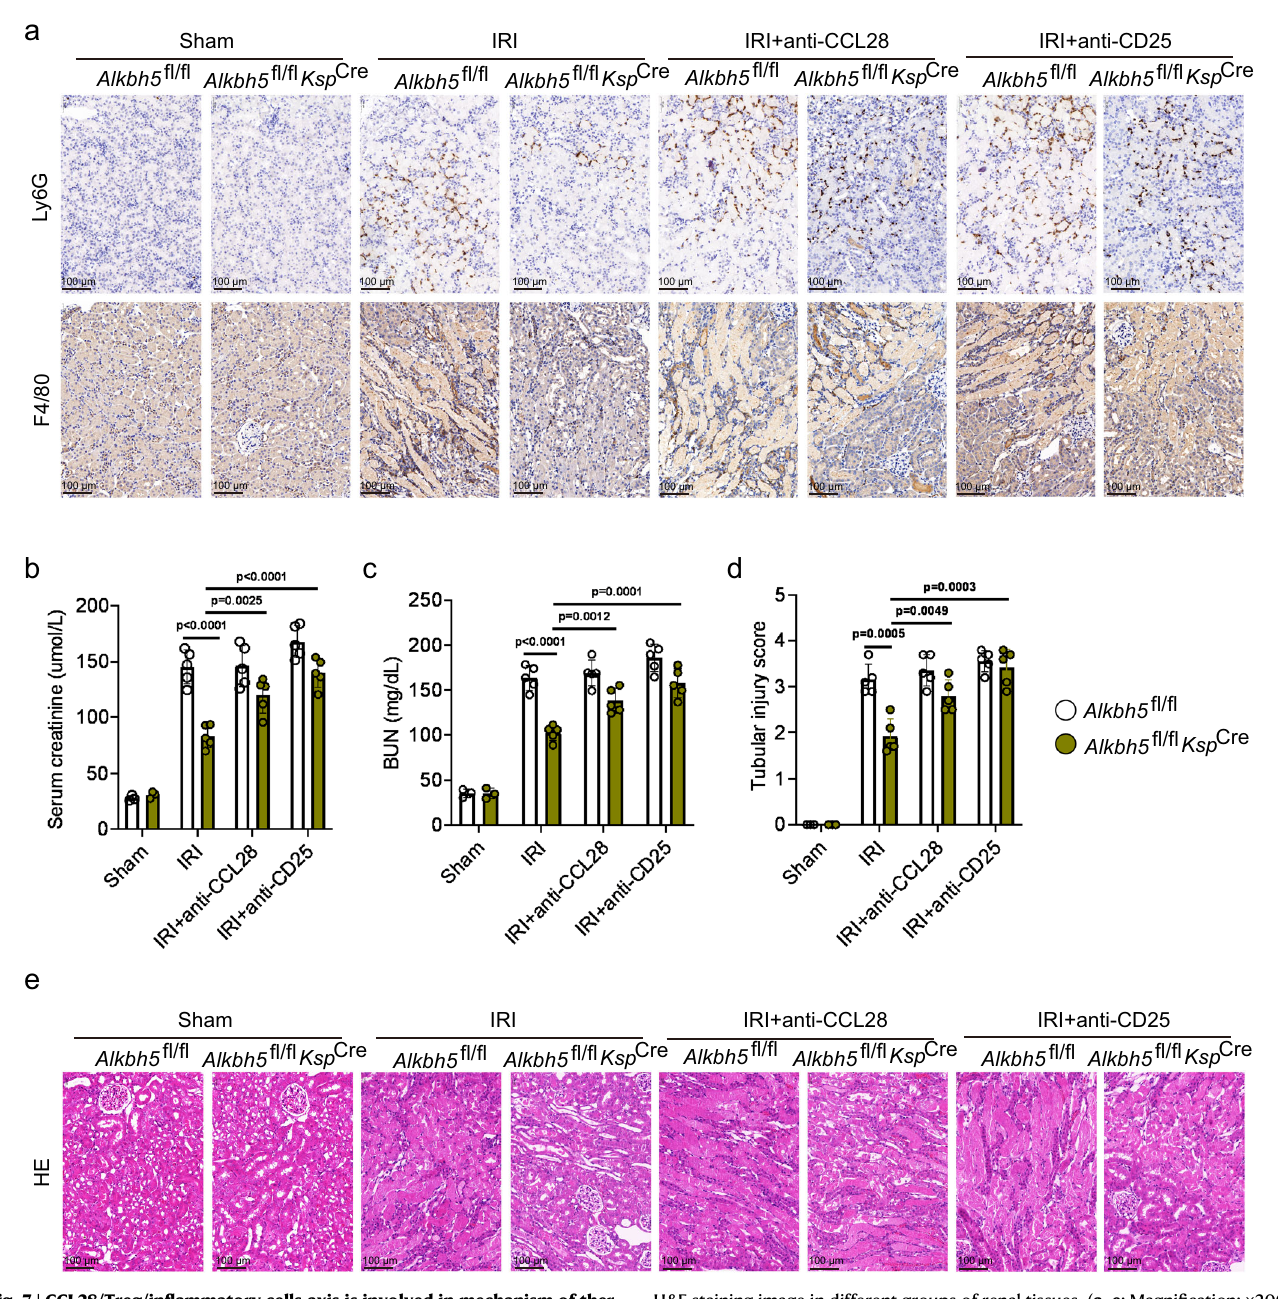
H&E staining image in different groups of renal tissues. ( a , e : Magni fi cation: ×200, Scale bar: 100 μ m). For b – d , Sham groups, n=3; other groups, n=5. Each data point represents one animal. Unpaired two-tailed Student ’ s t-test. Data are shown as